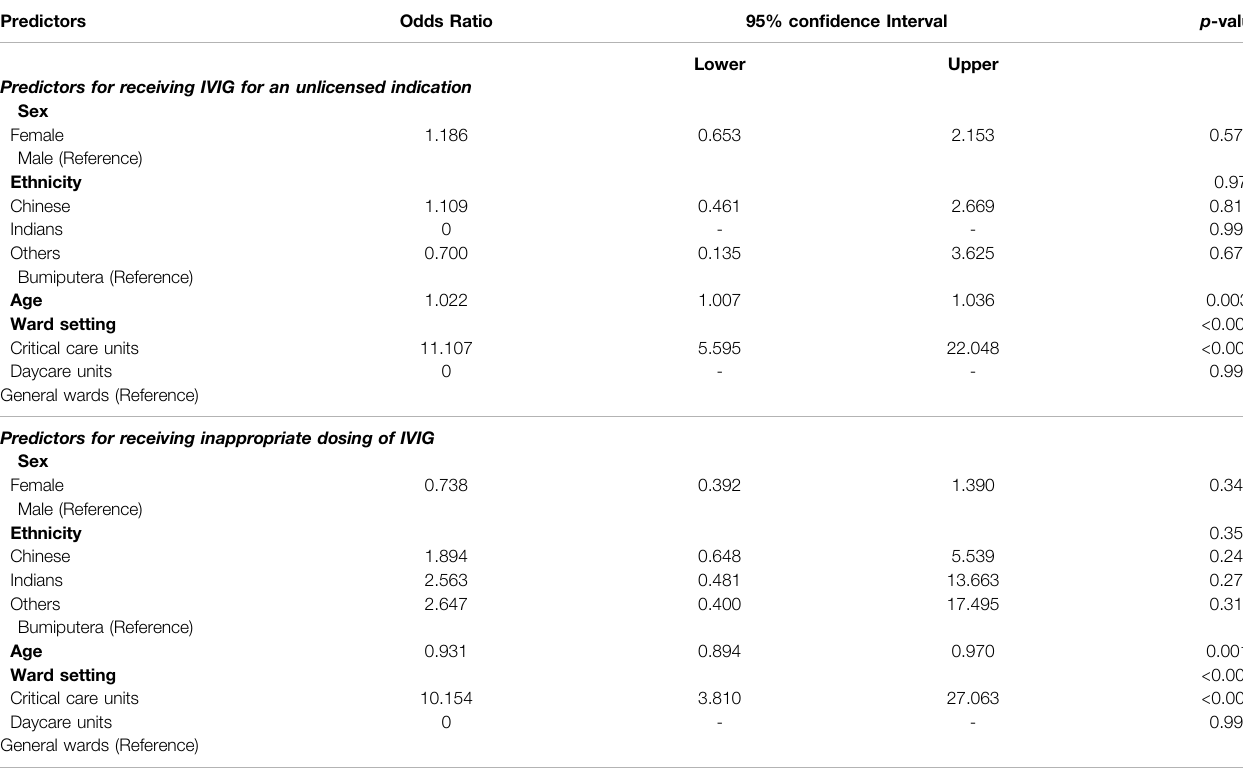
TABLE 3 | Predictors for receiving IVIG for an unlicensed indication and inappropriate dose of IVIG.